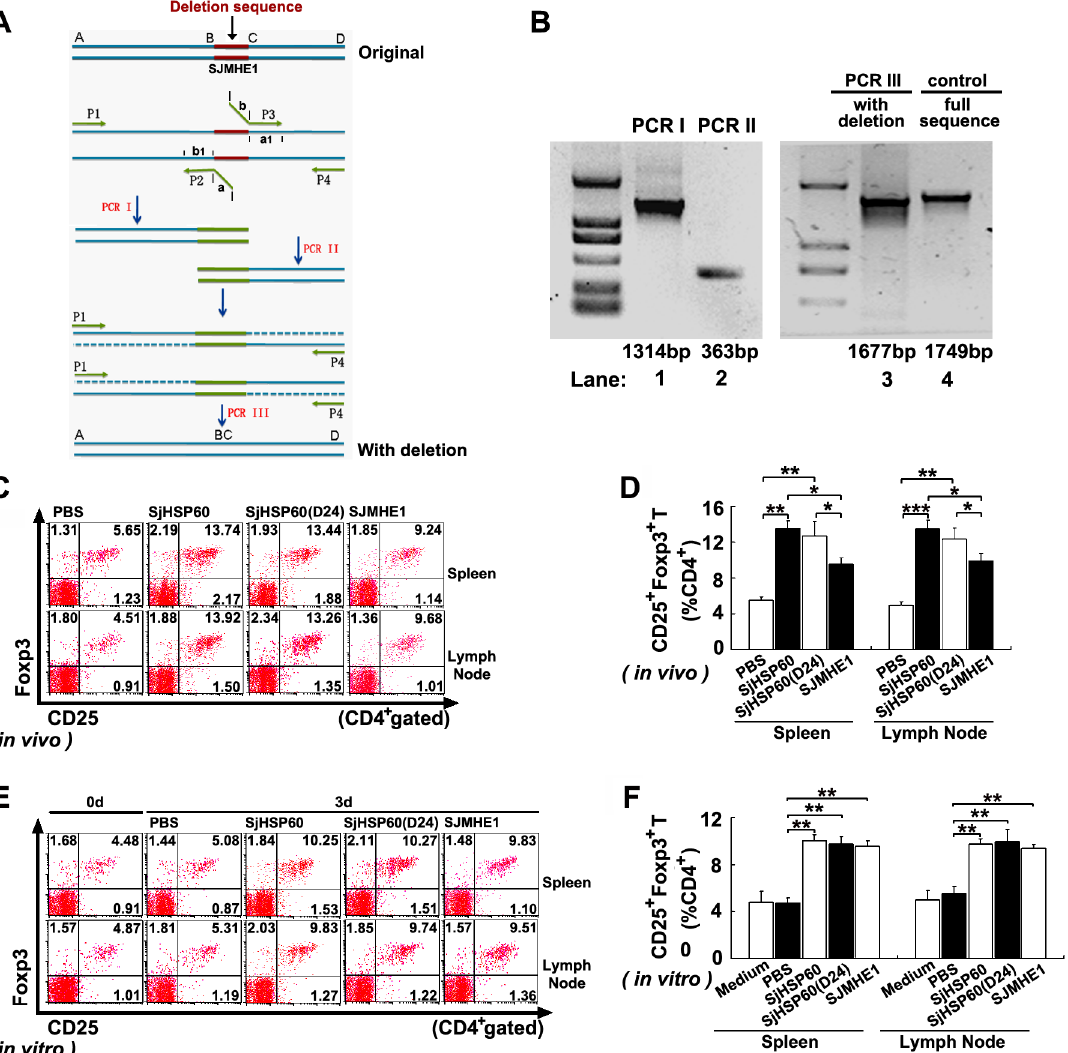
Fig 6. SJMHE1 motif is not necessary in Treg induction by SjHSP60. (A) Schematic of PCR design. SJMHE1 motif was deleted from original sequence of SjHSP60 (pGEX-SjHSP60) by PCRs in three steps (I, II and III) with four PCR primers (p1-p4) as described in Supporting Information. P1 and p2, p3 and p4, and p1 and p2 were used in PCR I, II, and III, respectively. Sequences “ a ” of p2 sequence and “ b ” of p3 were complementary respectively to the sequences of “ a1 ” and “ b1 ” regions (at right/left of deletion motif), respectively. pGEX-SjHSP60 was used as template in PCR I and PCR II. Mixed PCR1